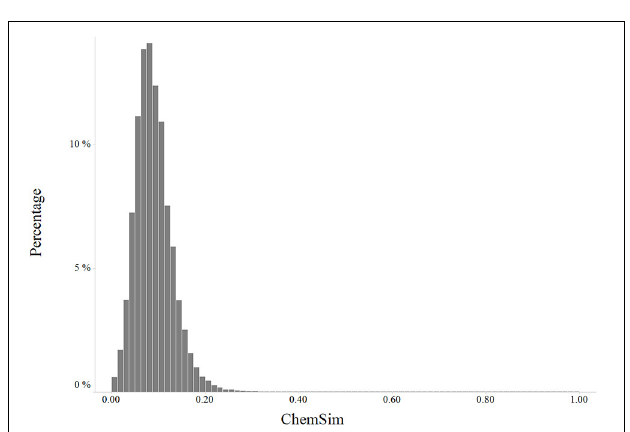
FIGURE 2 | Distribution of pairwise chemical similarity of LINCS